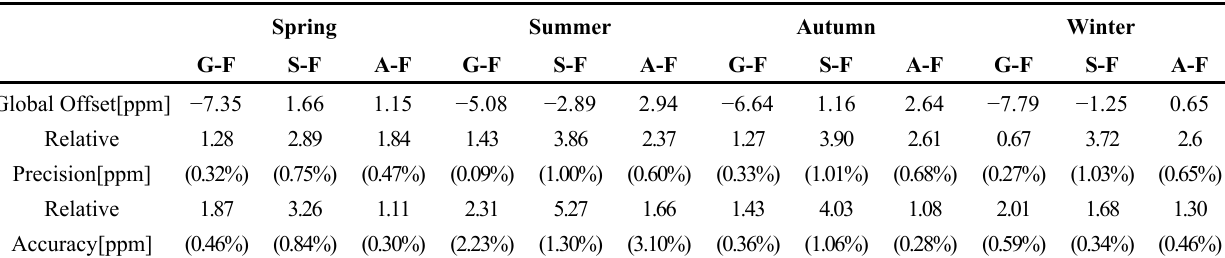
Table 6. Summary of Table